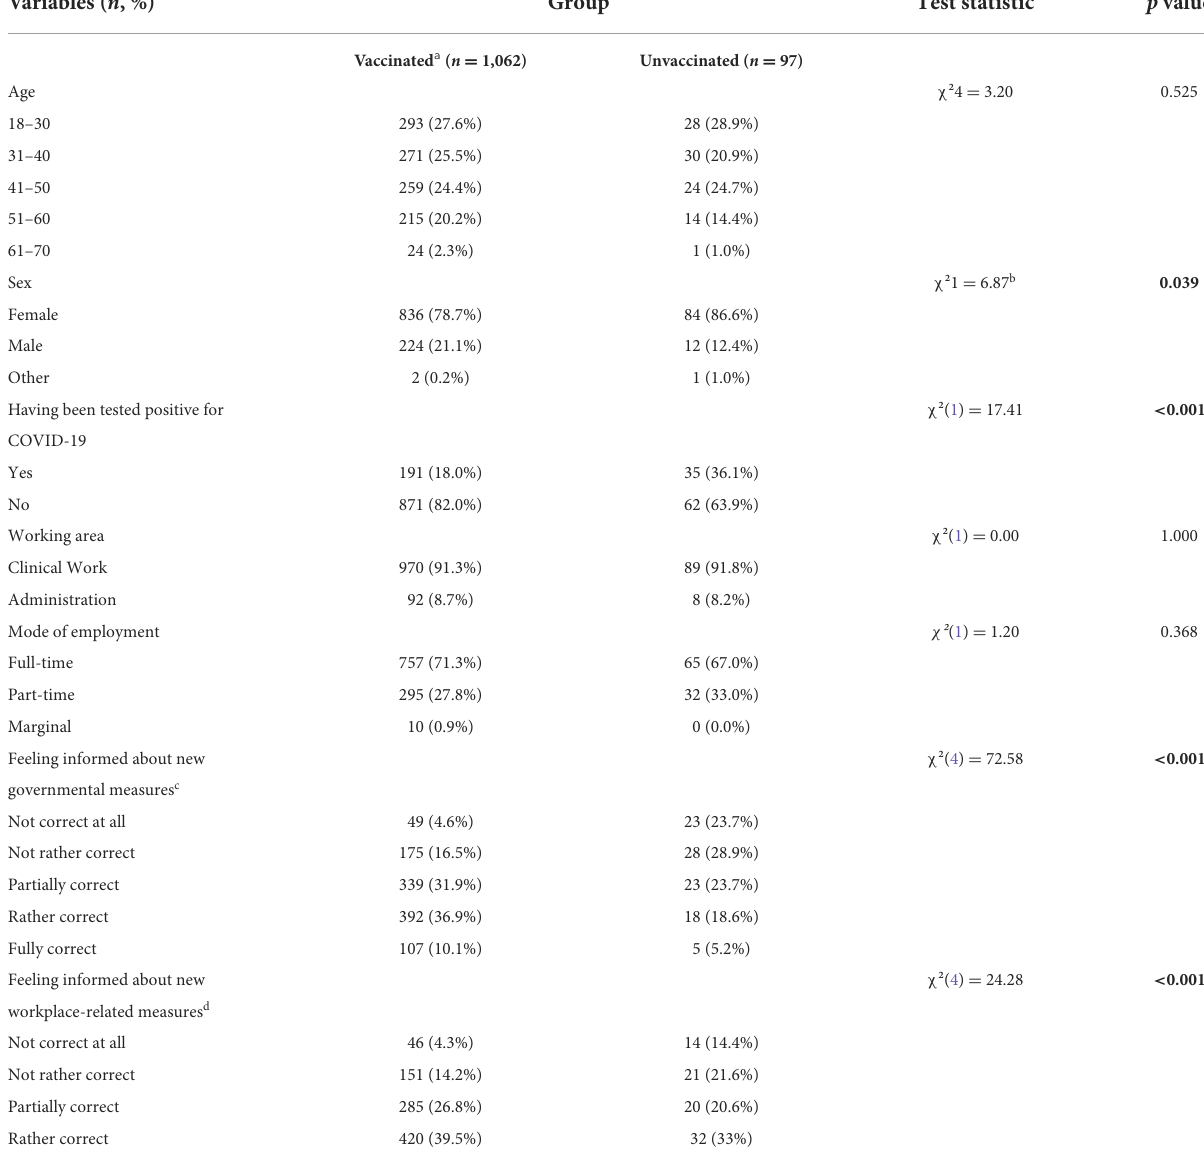
TABLE 3 Sociodemographic characteristics and differences between vaccinated and unvaccinated individuals ( n = 1,159). Variables ( n , %) Group Test statistic p value Vaccinated a ( n =